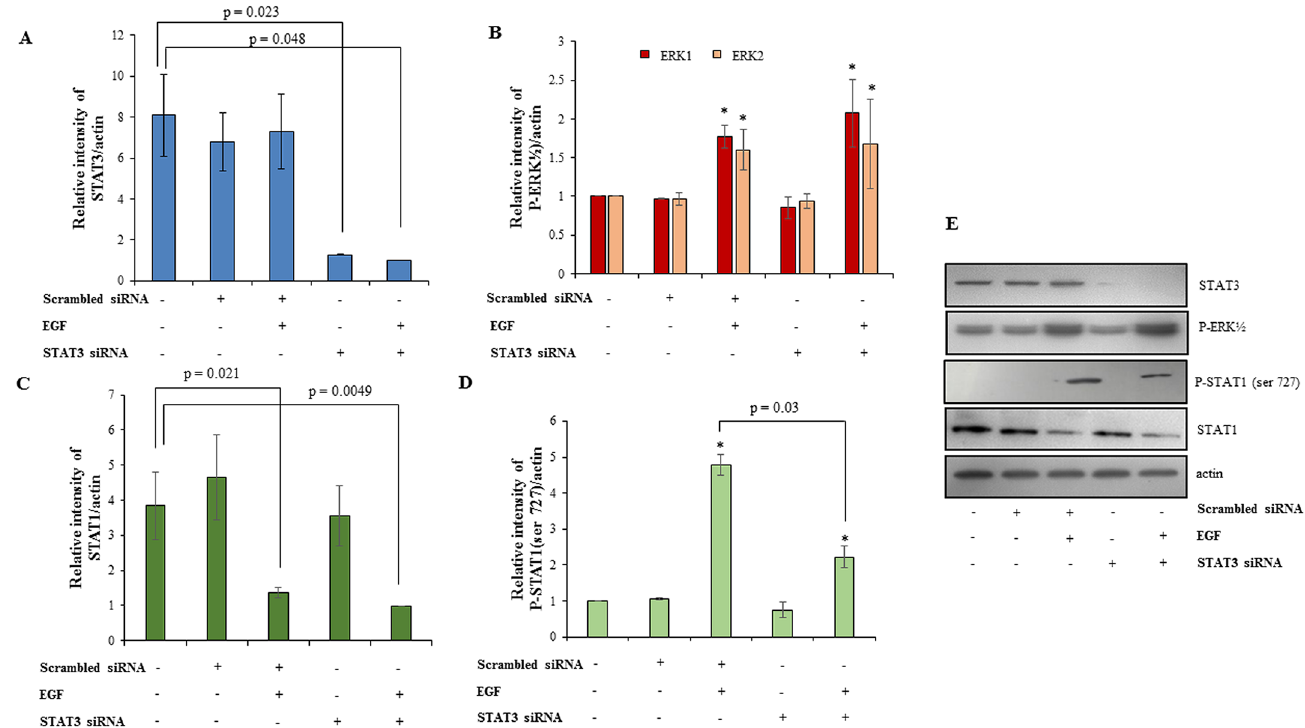
Fig 6. Effect of STAT3 silencing on phosphorylation of ERK ½ and STAT1 in presence/absence of EGF treatment. STAT3 was silencedin HTR-8/SVneo cells using siRNA as describedin Materials and Methods . The na ï vecells, scrambledsiRNA and STAT3 siRNA transfected cells were treated with EGF (10 ng/ml) for 60 min. Panel A shows densitometric plot of total STAT3 levels as comparedto actin either in presenceor absenceof EGF treatment to confirm silencingof STAT3. Panels B, C and D represent densitometric profiles of phosphorylated ERK ½ , total STAT1 and phosphorylated STAT1 ser727 respectively, as comparedto actin in na ï vecells, scrambledand STAT3 siRNA treated cells in presenceor absenceof EGF. Panel E shows the representative blots from one of the three independentexperiments. The data is shown as mean ± SEM of three independent experiments and band intensities were normalizedwith respect to loadingcontrols duringdensitometric analysis. * p < 0.05 with respect to untreated control cells.